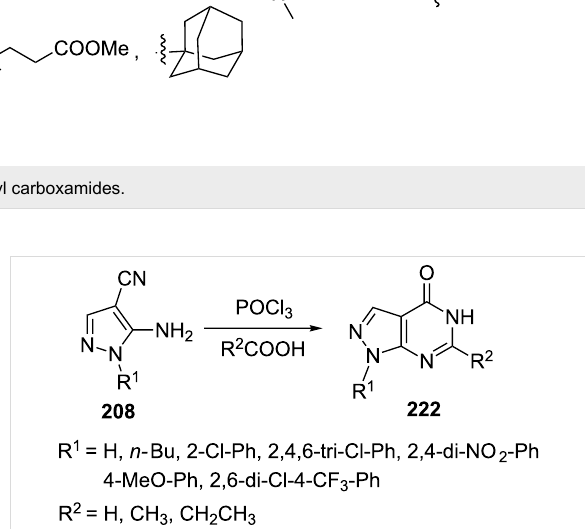
Scheme 60: One pot POCl 3 -catalyzed synthesis of 1-arylpyrazolo[3,4- d ]pyrimidin-4-ones. diation at 200 °C to give 4-aminopyrazolo[3,4- d ]pyrimidine ( 223 ) which on iodination with N -iodosuccinimide followed